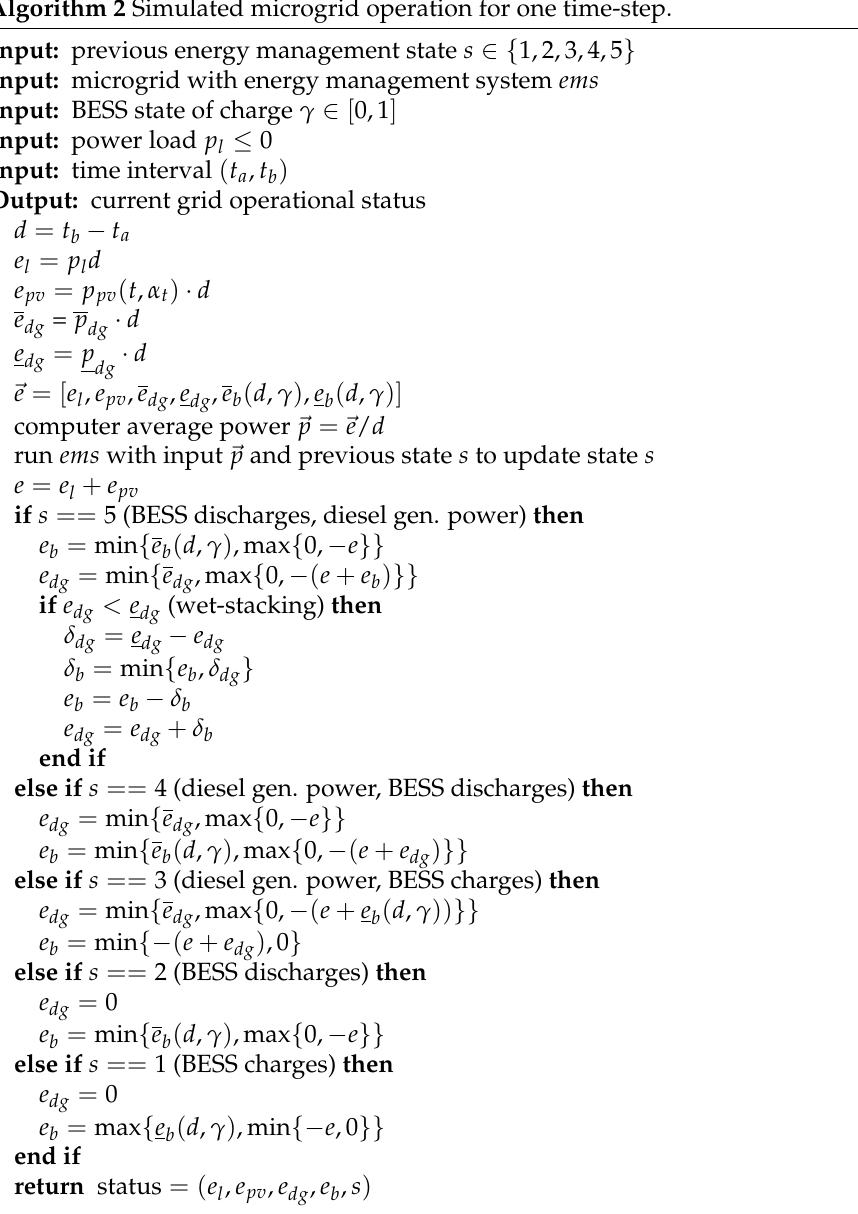
Algorithm 2 Simulated microgrid operation for one